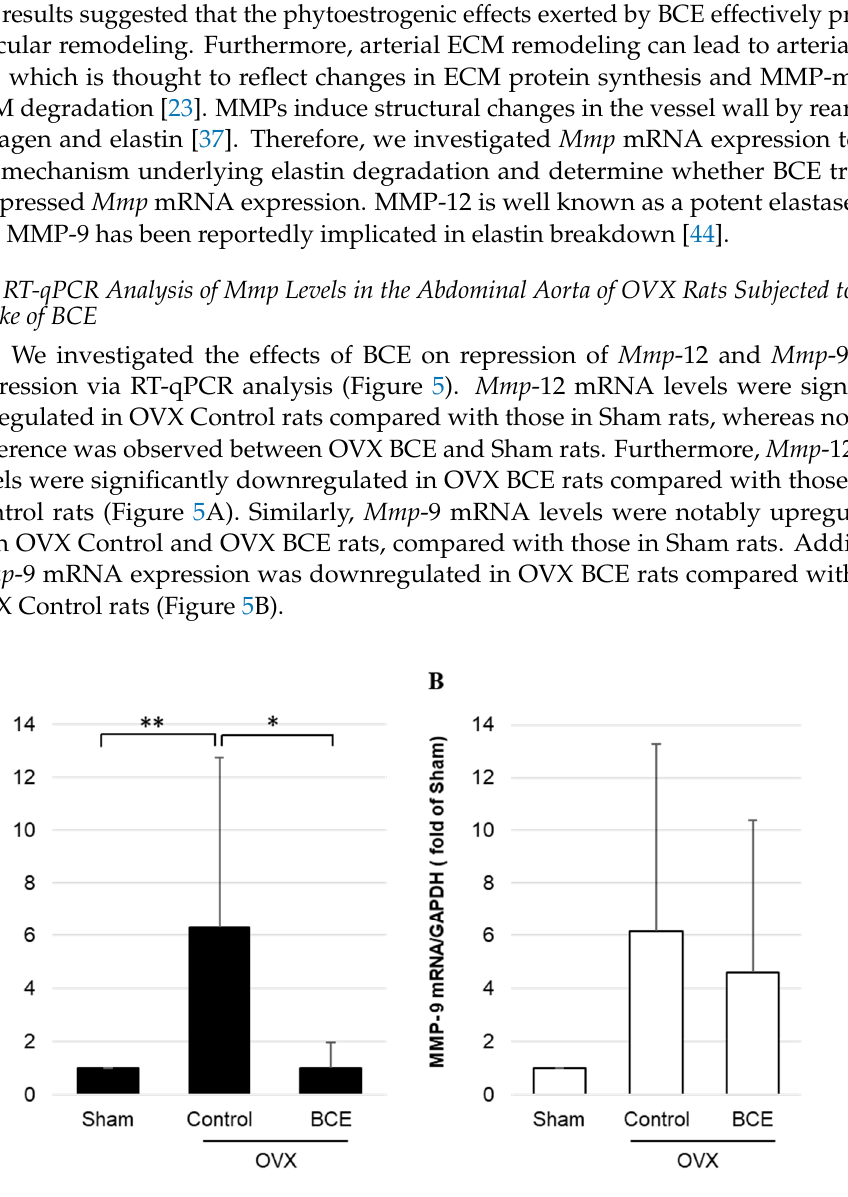
Figure 5. Mmp mRNA levels in OVX BCE rats. ( A ) Mmp -12 and ( B ) Mmp -9 mRNA levels quantified by RT-qPCR. Data are shown as the mean ± SEM of at least three independent experiments ( n = 9). * p < 0.05, ** p < 0.01, vs. Sham rats. Sham, sham surgery rats; Control, OVX rats without BCE treatment; BCE, OVX rats treated with 3% BCE; OVX, ovariectomized; BCE, blackcurrant ( Ribes nigrum L.) extract; MMP, matrix metalloproteinase; RT-qPCR, quantitative reverse-transcription polymerase chain reaction; SEM, standard error of the mean.